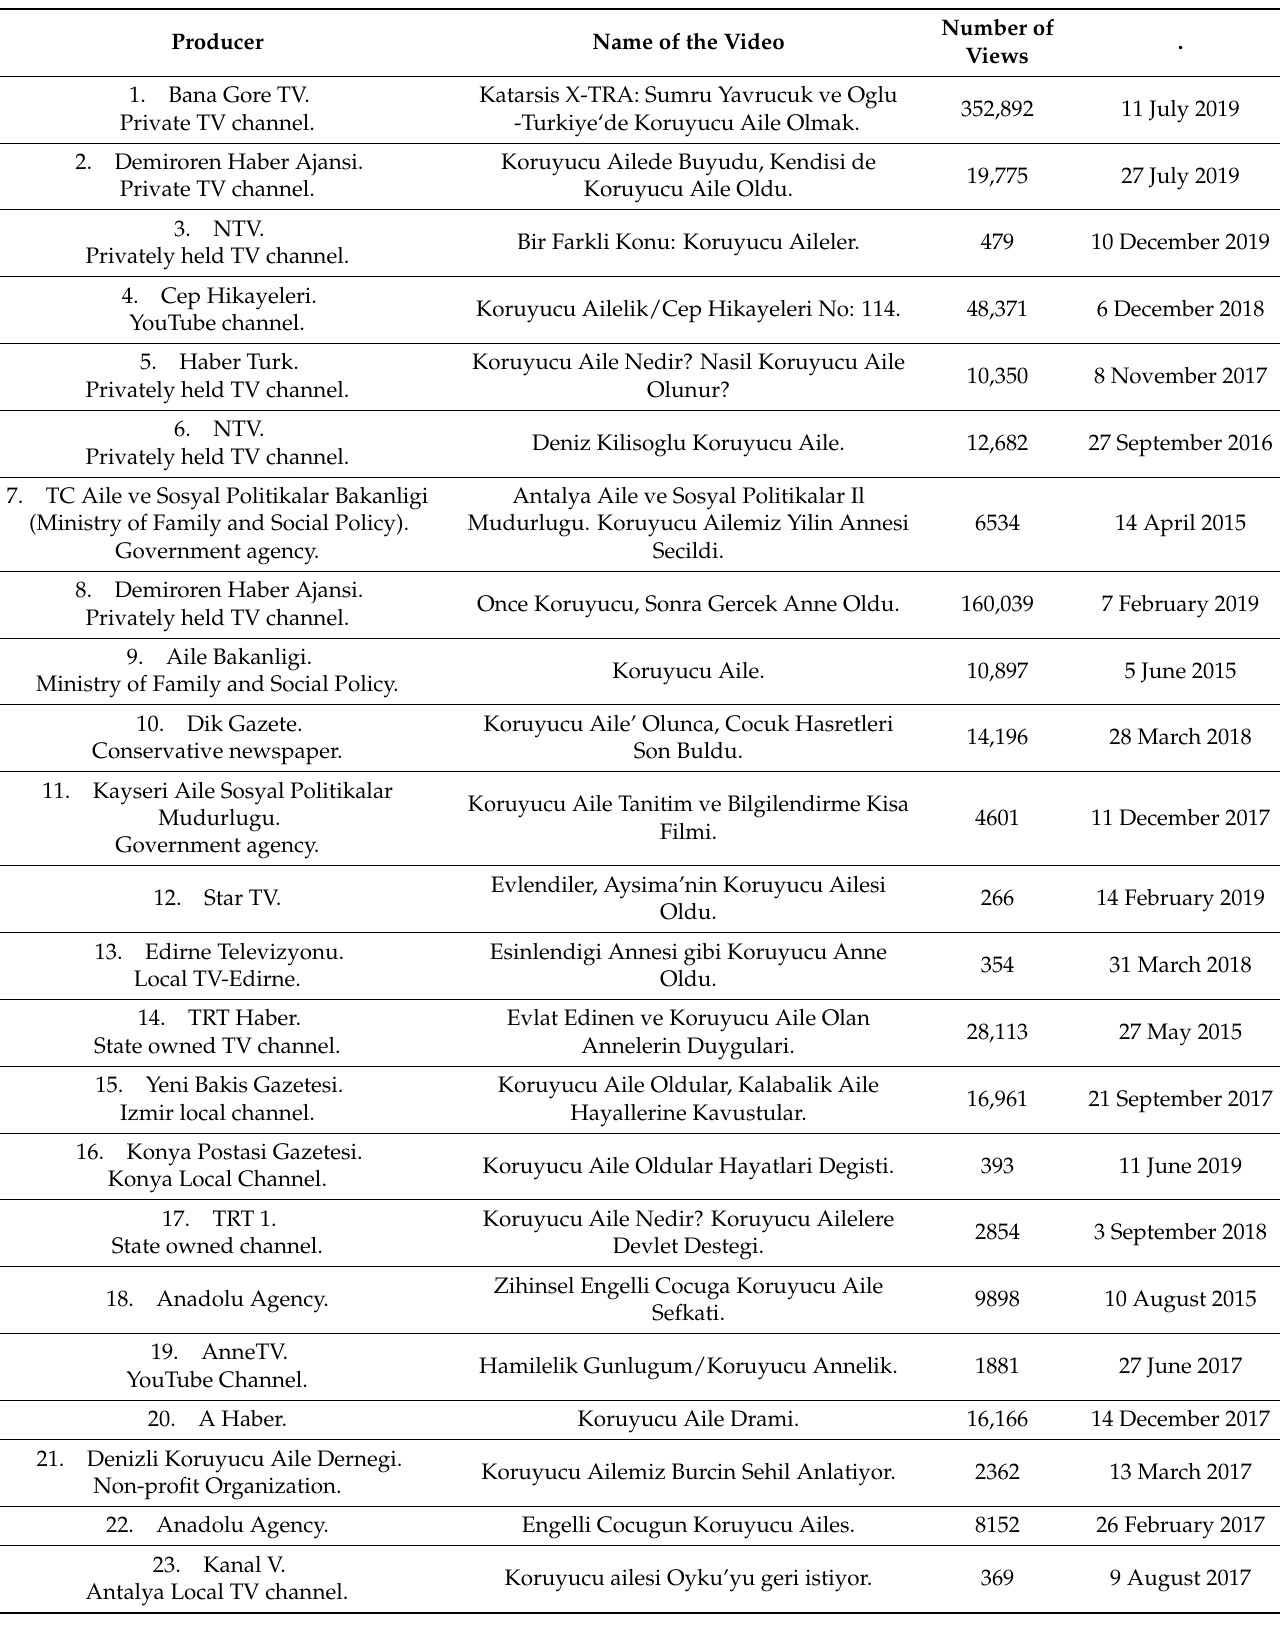
Table 1. TV Programs on Foster Care in